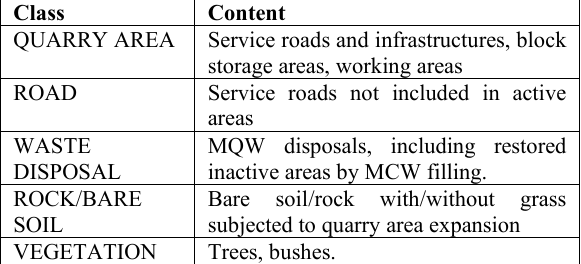
Table 2 . Classes used in land cover change digitizing.